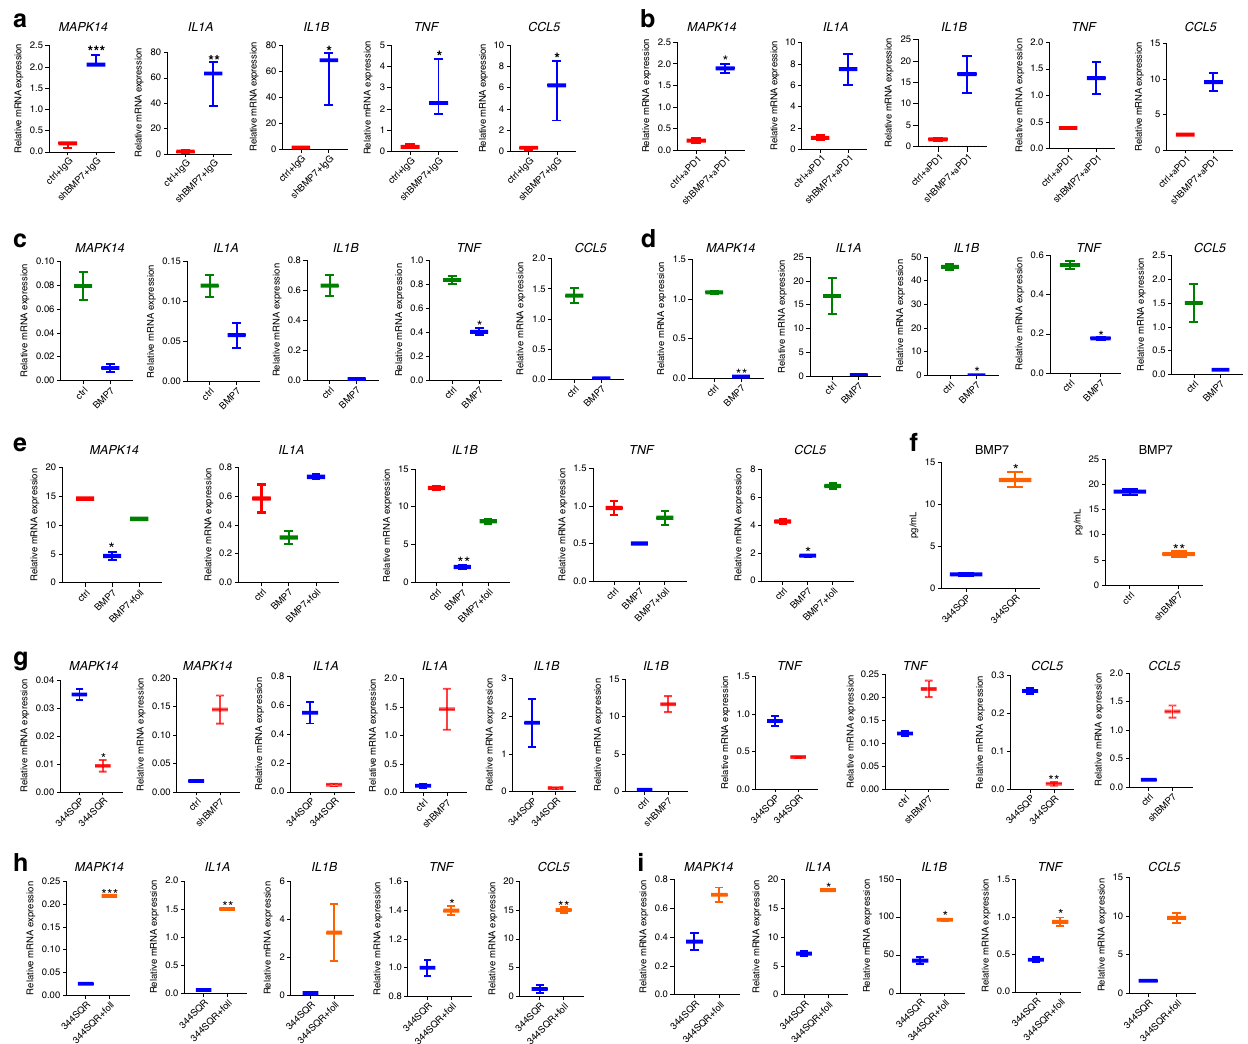
Fig. 3 BMP7 reduced macrophage-mediated proin fl ammatory signaling via MAPK14. a , b BMP7-knockdown and – control cells (0.5 × 10 6 ) were injected into 129 Sv/Ev mice and treated with IgG ( n = 3 biologically independent samples) or anti-PD1 (10 mg/Kg) ( n = 2 biologically independent samples) twice a week for 2 weeks. A week after the fi nal IgG and anti-PD1 treatment, tumor-in fi ltrating leukocytes (TILs) were collected, and expression of MAPK14 , IL1A , IL1B , TNF , and CCL5 were analyzed by quantitative PCR. Box-and-whisker plots show the minimum and maximum values. P values are from unpaired, two- sided t tests. Statistical signi fi cance was de fi ned as *, P < 0.05, **, P < 0.01, *** P < 0.001, and ****, P < 0.0001. c , d Quantitative PCR of MAPK14 , IL1A , IL1B , TNF , and CCL5 expression in RAW 264.7 cells c and peritoneal macrophages d untreated or treated with BMP7 (250 ng) for 24 or 48 h. Box-and-whisker plots show the minimum and maximum values of two independent experiments. e Quantitative PCR of MAPK14 , IL1A , IL1B , TNF , and CCL5 expression in RAW 264.7 cells untreated and treated with BMP7 (250 ng) or BMP7 plus follistatin (foll) (250 ng) for 24 h. Box-and-whisker plots show the minimum and maximum values of two independent experiments. f BMP7 levels in cell culture supernatant from 344SQP, 344SQR, and 344SQR ctrl and 344SQR shBMP7 cells analyzed by enzyme-linked immunosorbent assay. Box-and-whisker plots show the minimum and maximum values of two biologically independent samples. g Quantitative PCR of MAPK14 , IL1A , IL1B , TNF , and CCL5 expression in RAW 264.7 cells co-cultured with 344SQP or 344SQR, and 344SQR shBMP7 or 344SQR ctrl cells for 24 h. Box-and-whisker plots show the minimum and maximum values of two independent experiments. h , i Quantitative PCR of MAPK14 , IL1A , IL1B , TNF , and CCL5 expression in RAW 264.7 cells and peritoneal macrophages co-cultured with 344SQR cells or 344SQR cells plus follistatin (foll) (250 ng) for 24 or 48 h. CD45 expression was used as a housekeeping gene for quantitative PCR analysis. The comparative Ct method was used to calculate the relative abundance of mRNAs compared with CD45 expression. Box-and-whisker plots show the minimum and maximum values of two independent experiments. P values are from unpaired, two-sided t tests. Statistical signi fi cance was de fi ned as * P < 0.05, ** P < 0.01, *** P < 0.001, and **** P <